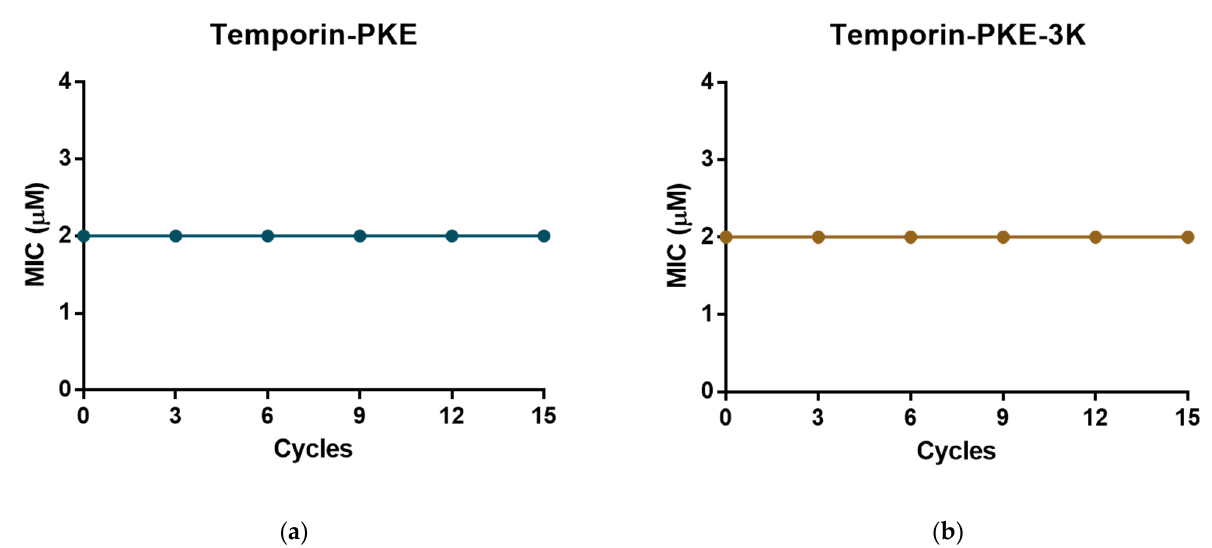
Figure 11. The assessment of resistance induction of ( a ) temporin-PKE and ( b ) temporin-PKE-3K in MRSA after 15 cycles. The vertical axis represents the MIC value (µM) against MRSA, and the horizontal axis means the number of passages.